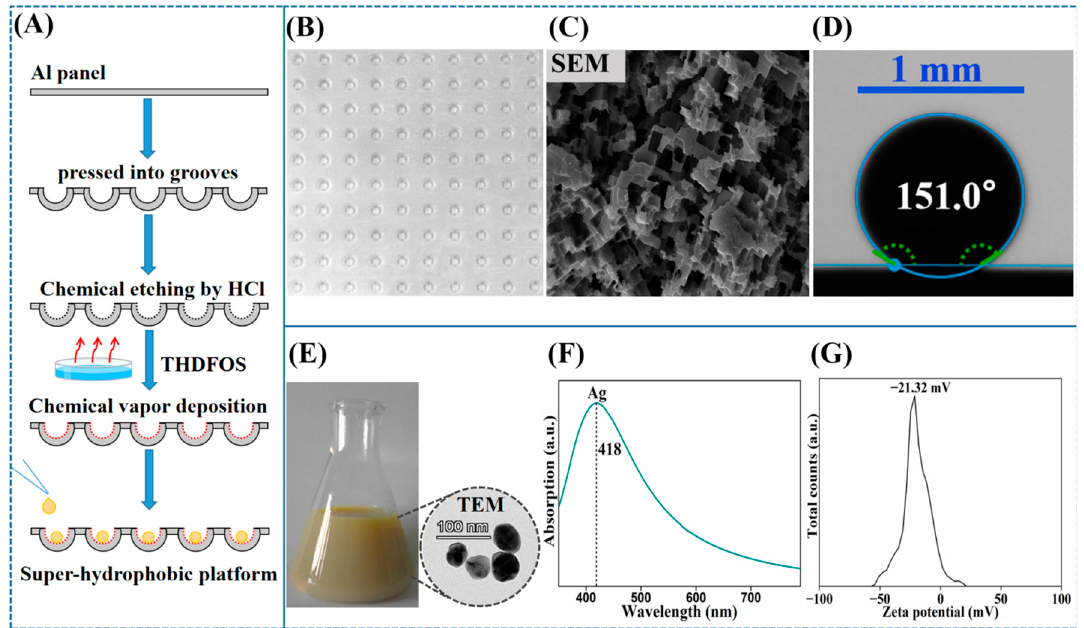
Figure 1. ( A ) Schematic of the procedure for preparing the super ‐ hydrophobic platform by chem ‐ ical etching and chemical vapor deposition. ( B ) Photograph of Al sheet ‐ based super ‐ hydrophobic platform. ( C ) SEM micrograph of the super ‐ hydrophobic grooved surface. ( D ) Optical image of a water droplet on the surface. ( E ) Photograph and TEM micrograph of the Ag NPs. ( F ) Ultraviolet–visible (UV) absorption spectrum of the Ag NPs. ( G ) Zeta potential of the Ag NPs.